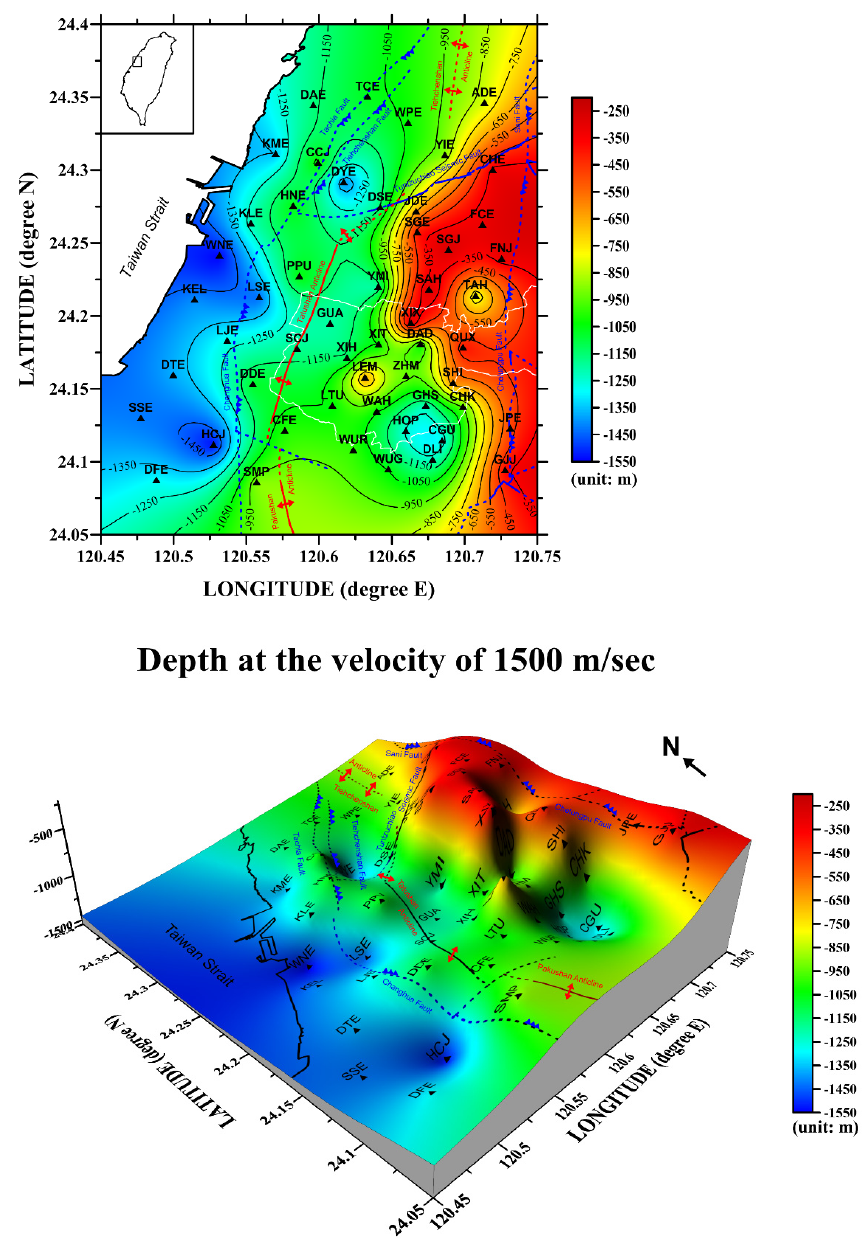
Figure 13. Contour map ( upper panel ) and 3D structure ( lower panel ) of the depth variations of the bedrock (Vs = 1500 m/s) in the Taichung area.